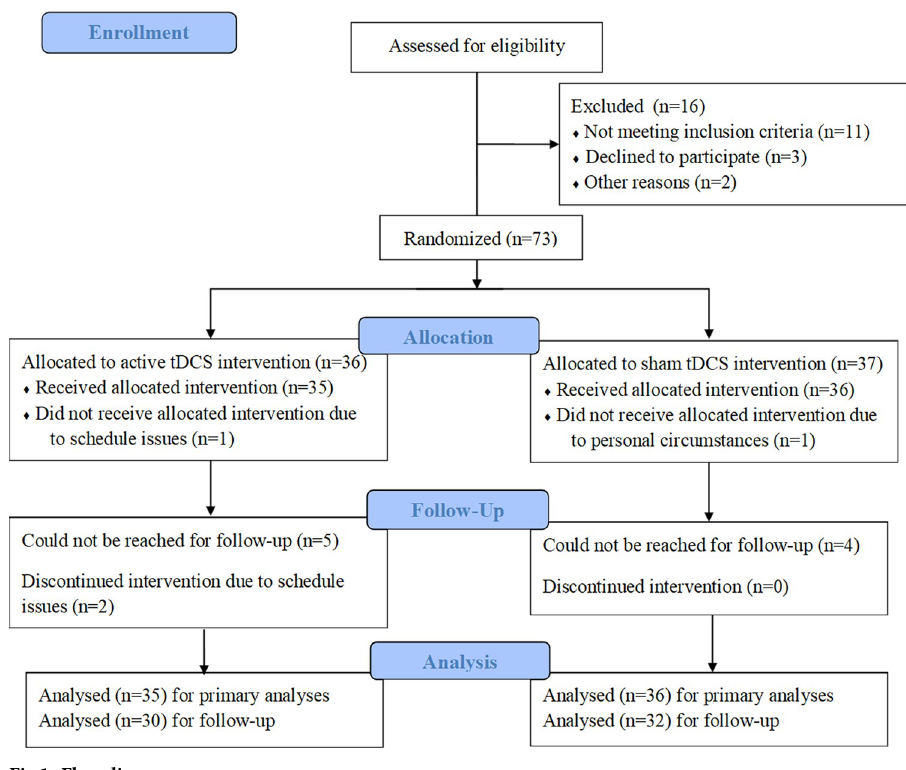
Fig 1. Flow diagram.